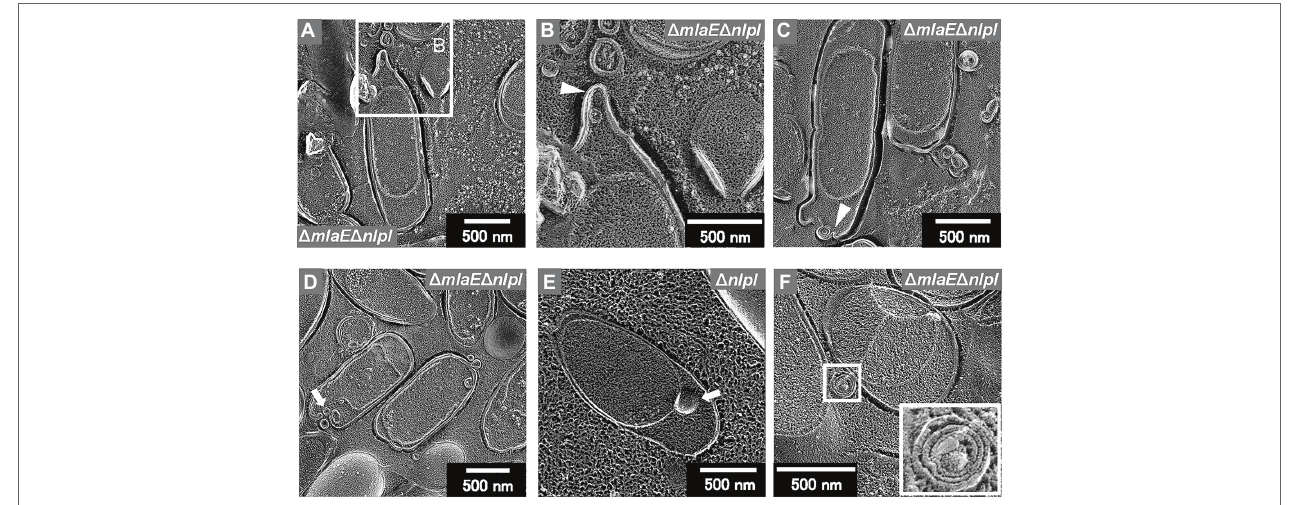
FIGURE 4 | Cross-section of plasmolyzed E. coli cells. (A–D) Magnified image of the structure of the plasmolyzed Δ mlaE Δ nlpI cells. The arrowheads indicate the blebbing from the outer membrane. (E) Magnified image of the structure of the plasmolyzed Δ nlpI cells. The arrows indicate the intracellular vesicle. (F) The multilamellar OMV generated from the Δ mlaE Δ nlpI cells.